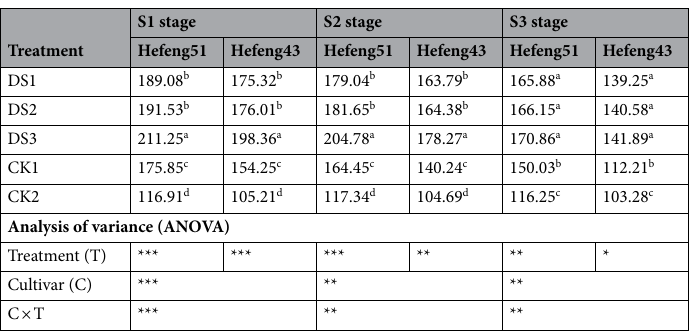
Table 4. Effects of foliar α-oxoglutarate and nitrogen on leaf glutamate content under drought stress (µg g −1 FW). Means with same letter within columns are not significantly different ( P < 0.05) using LSD test. ***, **, *Significance at 0.001, 0.01, and 0.05,